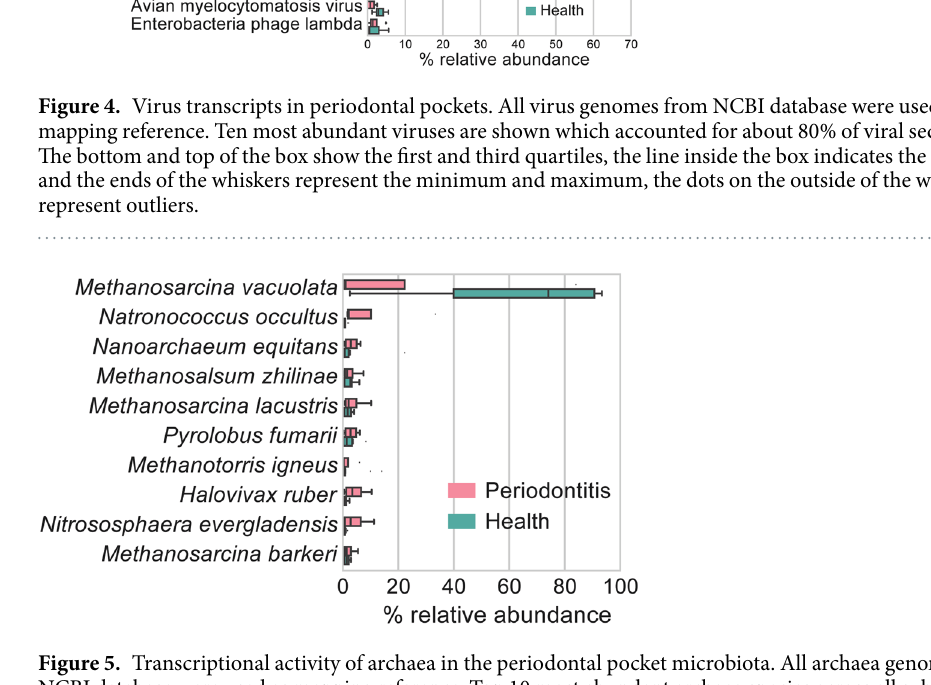
Figure 5. Transcriptional activity of archaea in the periodontal pocket microbiota. All archaea genomes from NCBI database were used as mapping reference. Top 10 most abundant archaea species across all subjects accounted for 72% of total archaeal reads. The bottom and top of the box show the first and third quartiles, the line inside the box indicates the median, and the ends of the whiskers represent the minimum and maximum, the dots on the outside of the whiskers represent